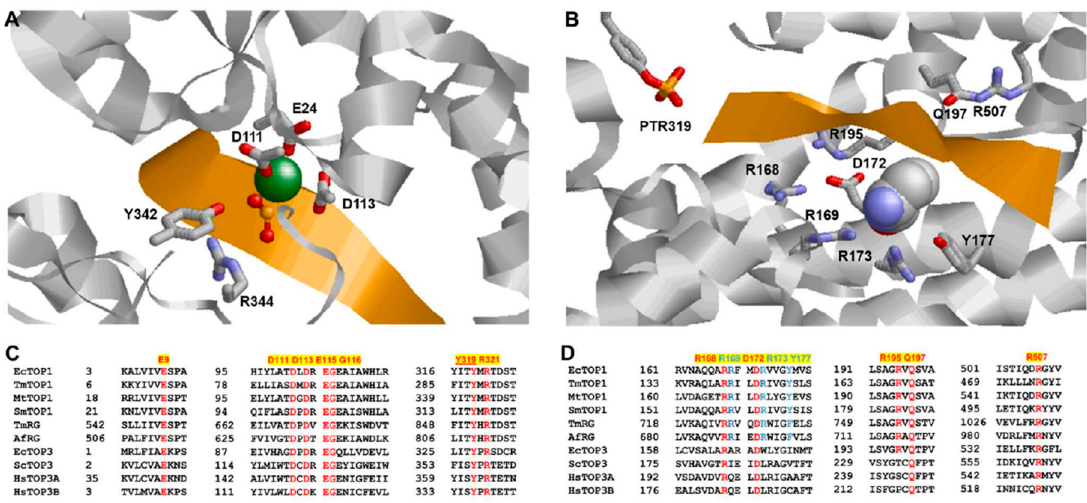
Figure 3. Type IA topoisomerase core domains interactions with the G-strand. ( A ) Active site of the M. tuberculosis topoisomerase I noncovalent complex (PDB 6CQ2) showing an interaction between the catalytic tyrosine and adjacent arginine with the scissile phosphate of the G-strand (in gold). A Mg 2+ ion (in green) interacts with the scissile phosphate and TOPRIM acidic residues. ( B ) Structure of the E. coli topoisomerase I covalent complex (PDB 3PX7) showing the positioning of the G-strand by residues interacting with the G-strand backbone and a cytosine base (shown in the space-filling display) at a distance of four nucleotides from the phosphoryl tyrosine (PTR) formed from the cleavage of the G-strand. ( C ) Alignment of residues strictly conserved at the active site and type IA topoisomerases including bacterial topoisomerase I, reverse gyrase (RG) and topoisomerase III from prokaryotes and eukaryotes. Species represented include Ec: E. coli , Tm: Thermotoga maritima . Mt: Mycobacterium tuberculosis , Sm: Streptococcus mutans , Af: Archaeoglobus fulgidus , Sc: Saccharomyces cerevisiae , Hs: Homo sapiens. ( D ) Alignment of residues (shown in red) that are strictly conserved in type IA topoisomerases for interacting with the G-strand backbone. Residues conserved for the specific binding of a cytosine base 4 nucleotides upstream of the scissile phosphate are shown in blue.